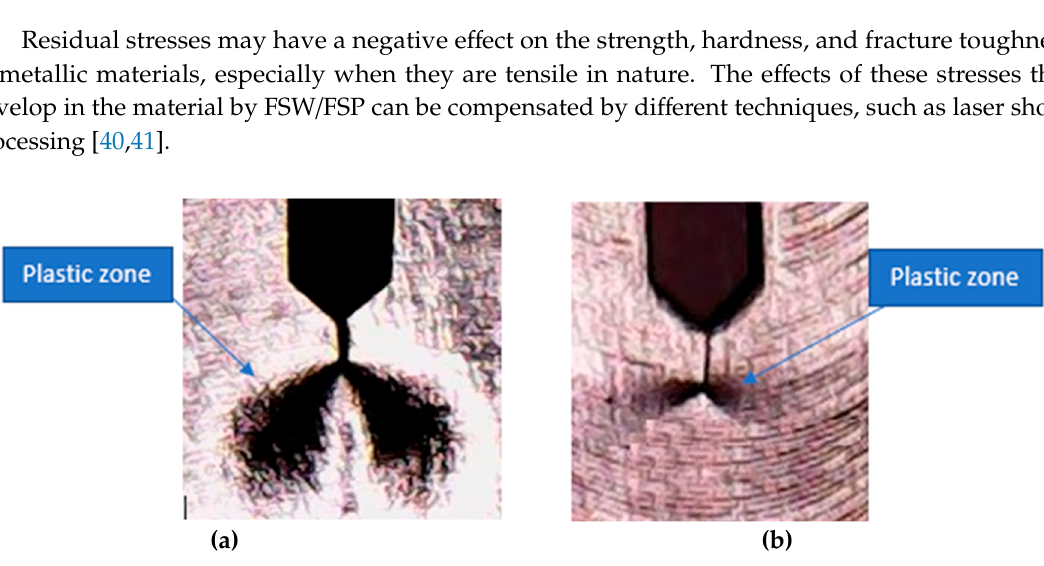
Figure 15. C(T) sample plastic zone after fracture toughness test: ( a ) BM, ( b ) FSPed metal.